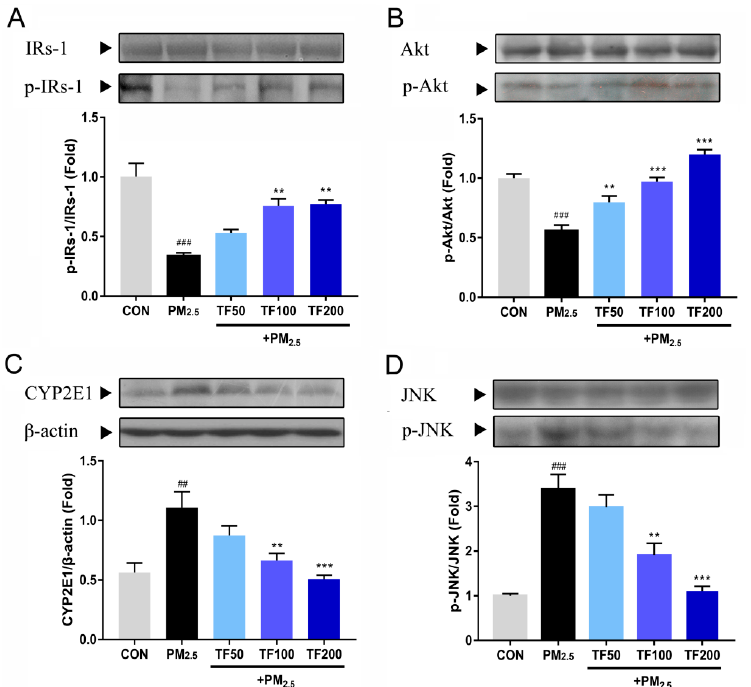
Figure 5. Effects of TF on insulin receptor substrate-1 (IRs-1), protein kinase B (Akt), cytochrome P450 2E1 (CYP2E1), and c-jun N-terminal kinase (JNK) in the liver tissue of PM 2.5 exposure induced NAFLD mice. ( A ) IRs-1, p-IRs-1, ( B ) Akt, p-Akt, ( C ) CYP2E1, ( D ) JNK, and p-JNK expression were probed by western blotting. All the results were presented as mean ± SE ( n = 3). ## p < 0.01, ### p < 0.001 vs. the CON group; ** p <0.01, *** p < 0.001 vs. the PM 2.5 group.